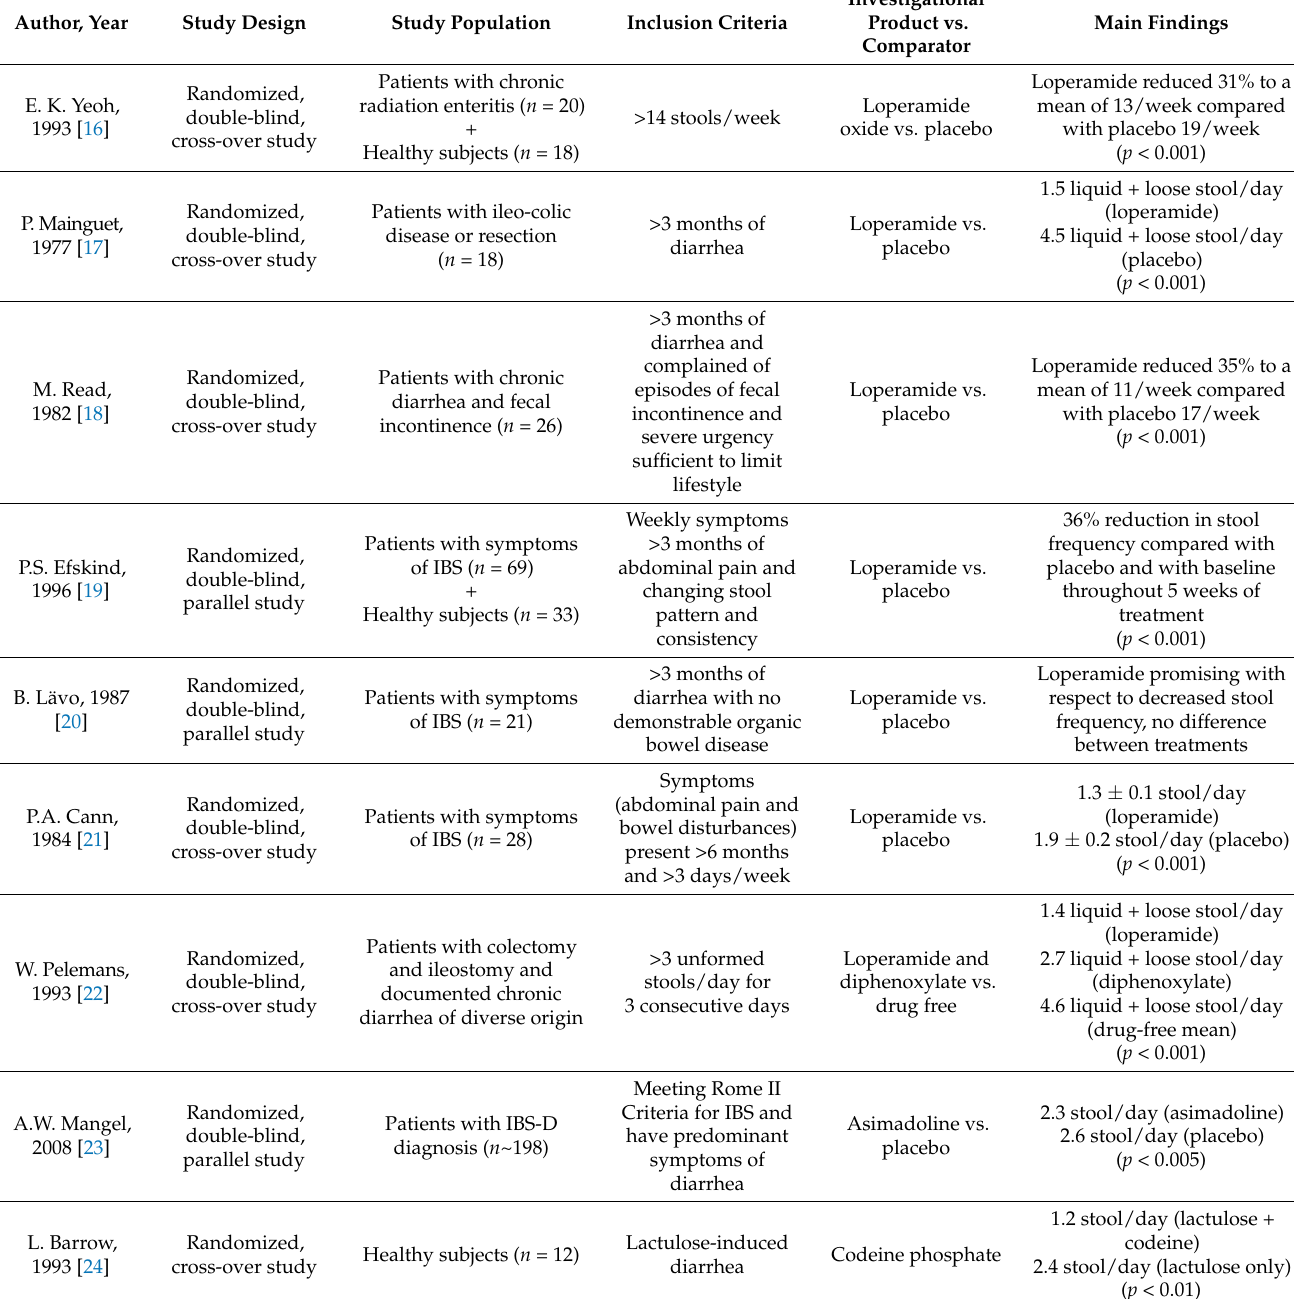
Table 1. Stool frequency